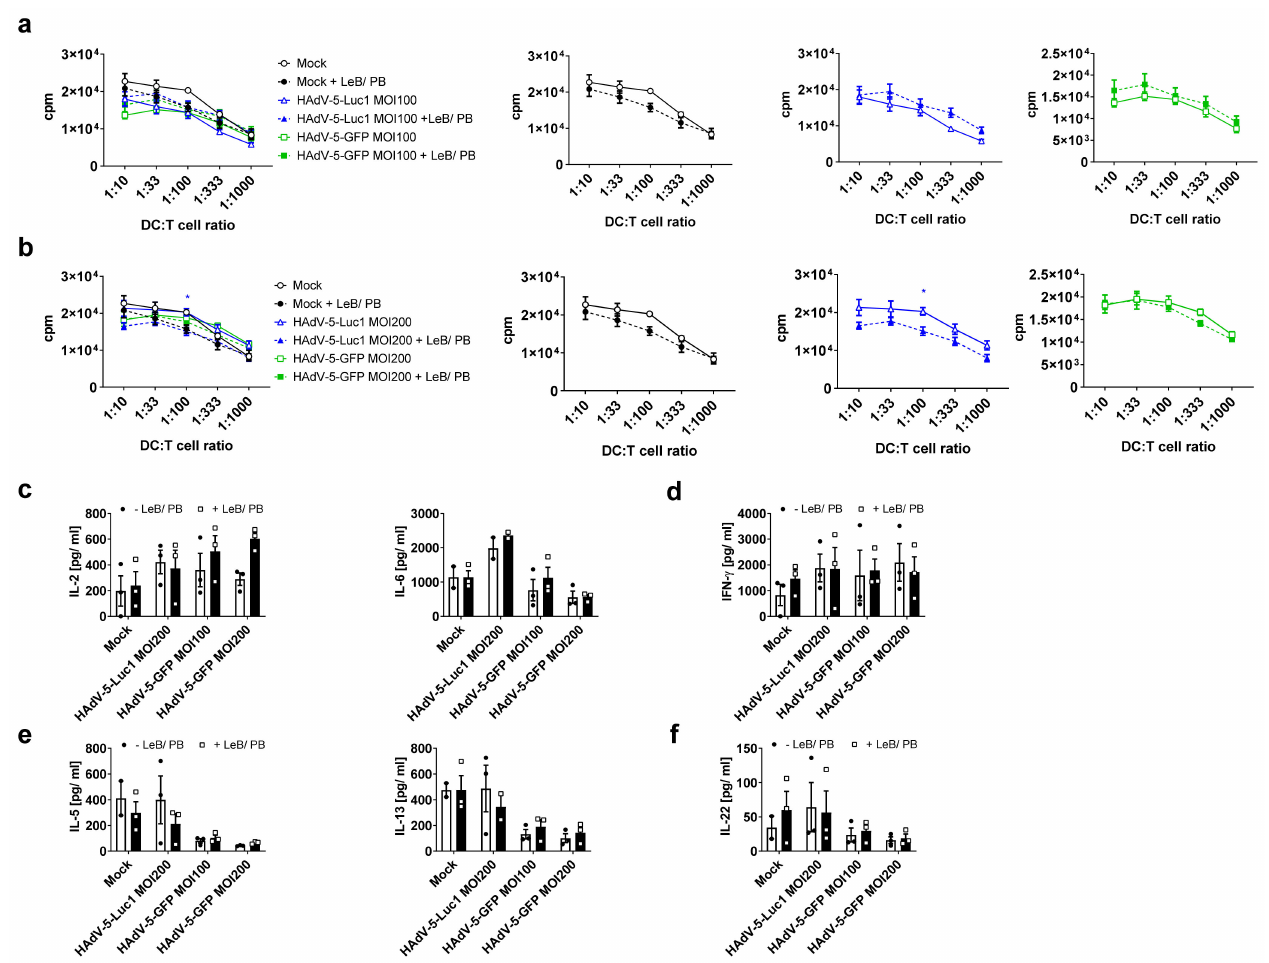
Figure 6. Enhanced adenoviral transduction efficacy using LentiBOOST ® /Polybrene retains the functionality of human mDCs. Mature dendritic cells were transduced with HAdV-5-Luc1 or HAdV- 5-GFP at a MOI of 100 and 200 or PBS (“Mock”) in combination with LentiBOOST ® /Polybrene (+LeB/PB) or water only ( − LeB/PB), for 48 h. ( a , b ) Allogeneic MLR assays with mature DCs transduced with HAdV-5-Luc1/HAdV-5-GFP at a MOI of 100 ( a ) and a MOI of 200 ( b ). Mature DCs and T cells, derived from the non-adherent fraction (NAF) of peripheral blood mononuclear cells (PBMCs), were co-cultivated at the indicated ratios for 72 h and subsequently pulsed with 1 µ C/well [H3]-thymidine for 16 h. Thymidine uptake was assessed using a 1450 MicroBeta counter. ( c – f ) Cell-free supernatants derived from MLR assays described in ( a , b ) were analyzed by CBA for their content of cytokines, 72 h after co-culture. ( a – f ) Data are mean ± SEM of three independent experiments with cells derived from different healthy donors. Two-way ANOVA and Sidak correction were performed. * p < 0.05, bars without annotation are not significant ( p > 0.05) in comparison to the respective condition–LeB/PB. Black circles represent conditions without LentiBOOST ® /Polybrene, white squares represent conditions with LentiBOOST ®